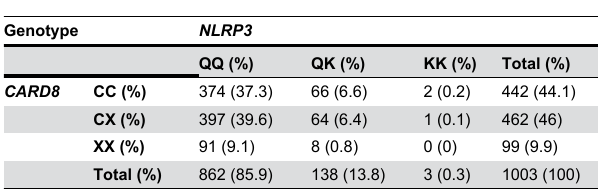
Table 1. Genotype frequencies (%) of the Q705K (rs35829419) in the NLRP3 gene and C10X (rs2043211) in the CARD8 gene and in combination with each other in healthy blood donors (n=1003).